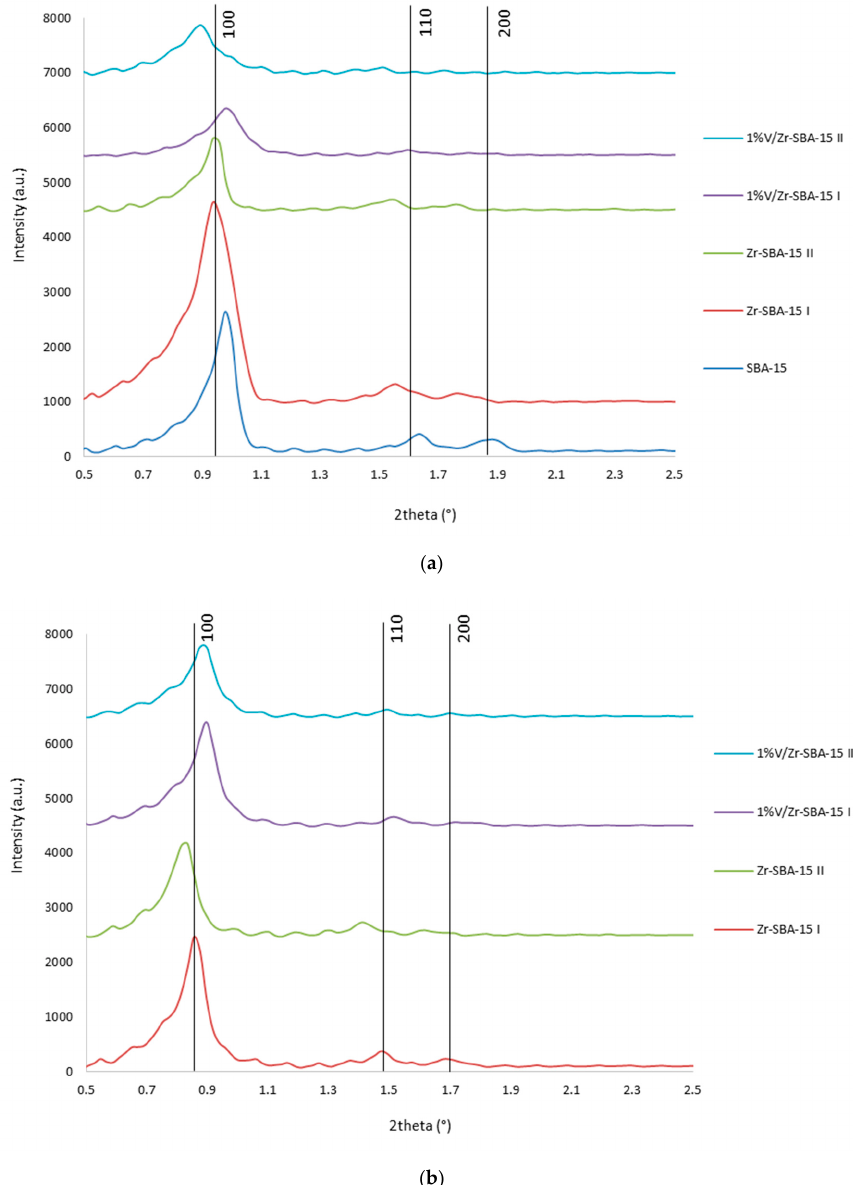
Figure 2. Small angle XRD diffraction pattern of Zr ‐ SBA ‐ 15 supports and vanadium catalysts: fresh ( a ) and used ( b ). and used ( b